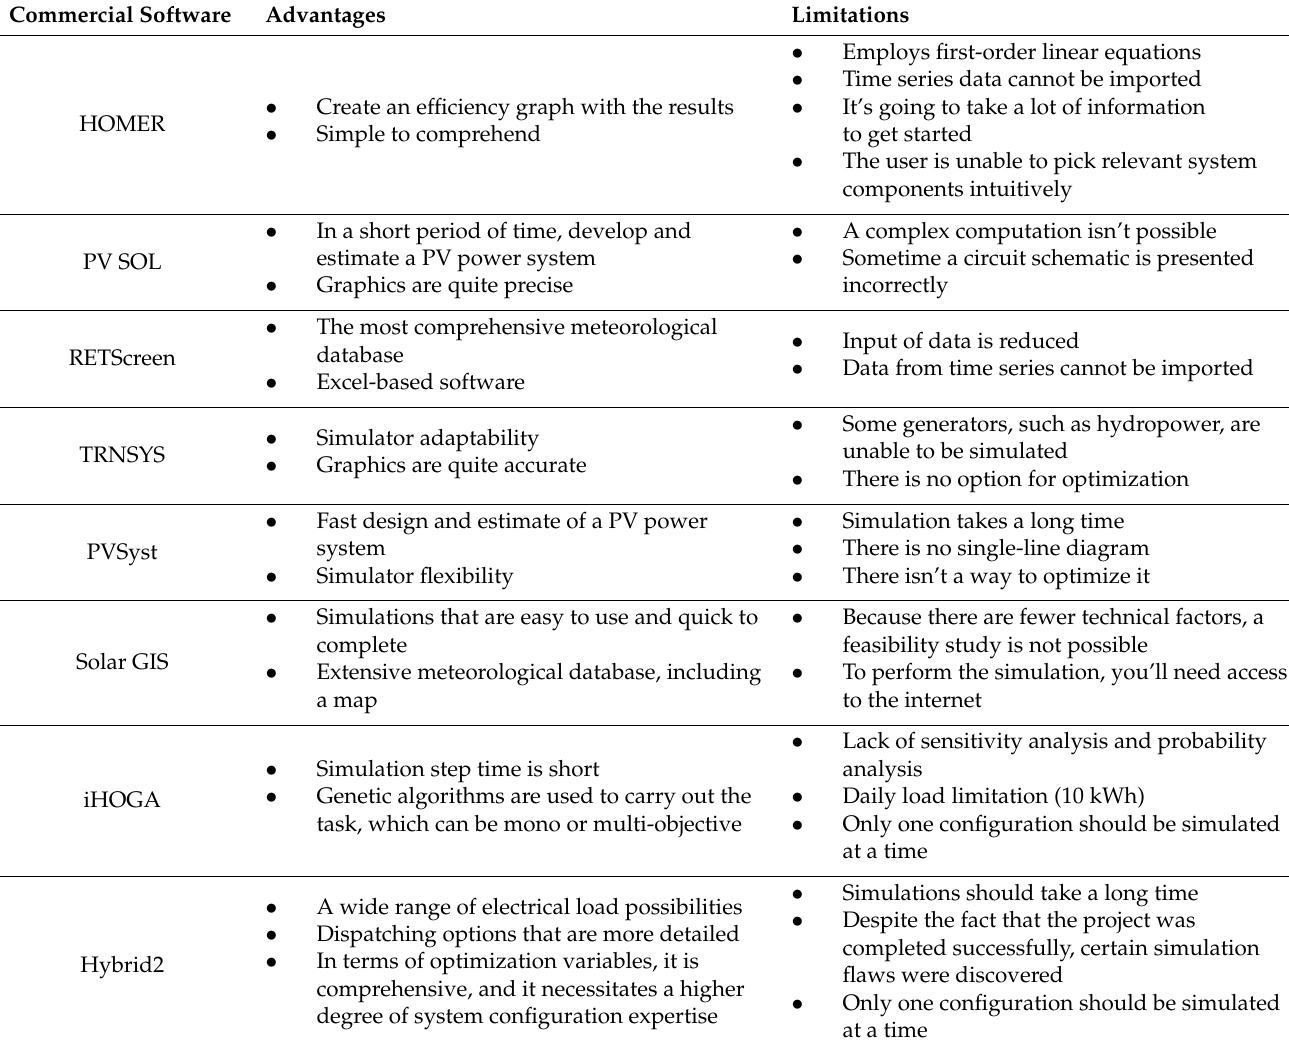
Table 7. Evolution of different scaling approaches (professional tools) used in hybrid system